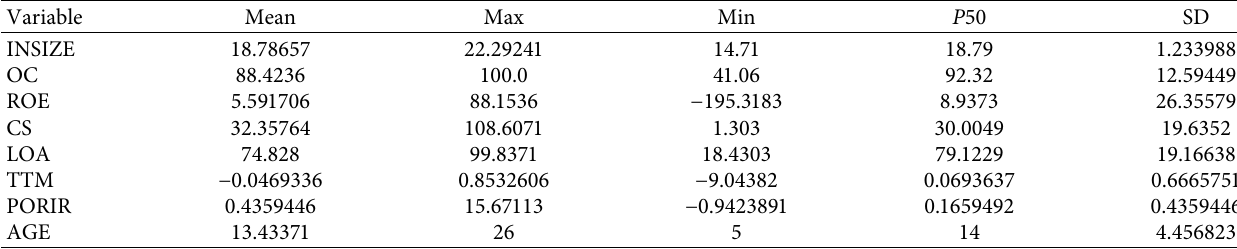
Table 2: Descriptive statistics of the overall sample.